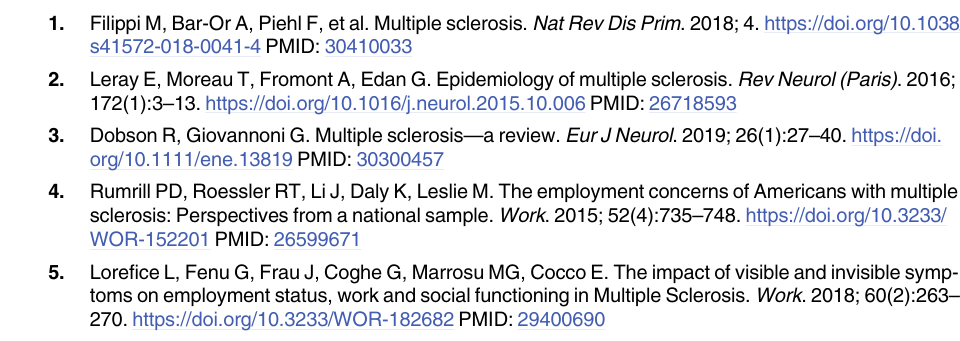
S1 Table. Detailed search strategy in PubMed, Scopus, SciVerse Science Direct and Web of Science. S2 Table. Minimal data set underlying the results and full description of the articles included in the review. NA = Not Applicable. � The JBI Critical Appraisal Checklist for Studies Reporting Prevalence Data was used for the risk of bias assessment, with more stars equalling lower risk. S1 Fig. Funnel plot of studies included in the analysis (unemployment). S2 Fig. Funnel plot of studies included in the analysis (early retirement). S3 Fig. Meta-regression (random-effects model) of the prevalence of early retirement according to